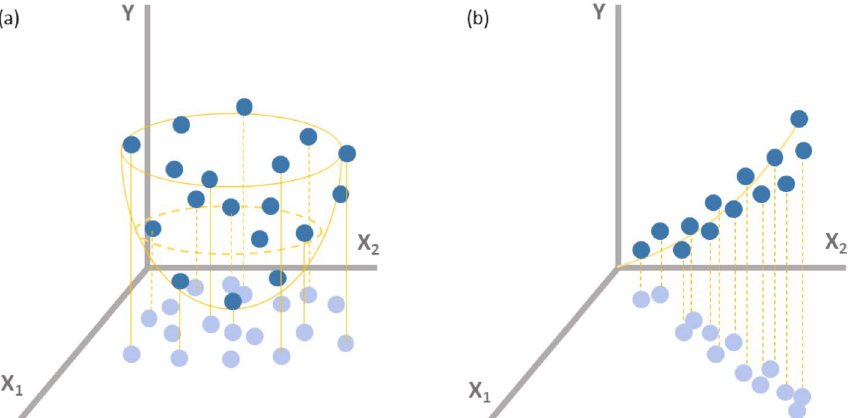
Figure 1. Data distributions along with simple ML models consisting of two input features (x 1 and x 2 ) and an output feature (y). ( a ) A more general data distribution available only for a forward ML prediction model, the parabolic surface represents a forward ML model. No correlation between x 1 and x 2 . ( b ) A very specific data distribution case, wherein both the forward and inverse ML prediction models are available, the thin solid curve represents both the forward and inverse ML models. Due to a strong correlation between x 1 and x 2 , either of them could be considered substantially non-existent. The data projection on the x 1 –x 2 plane, marked in tansparent blue, shows the IID random status in ( a ) and the severe correlation in ( b